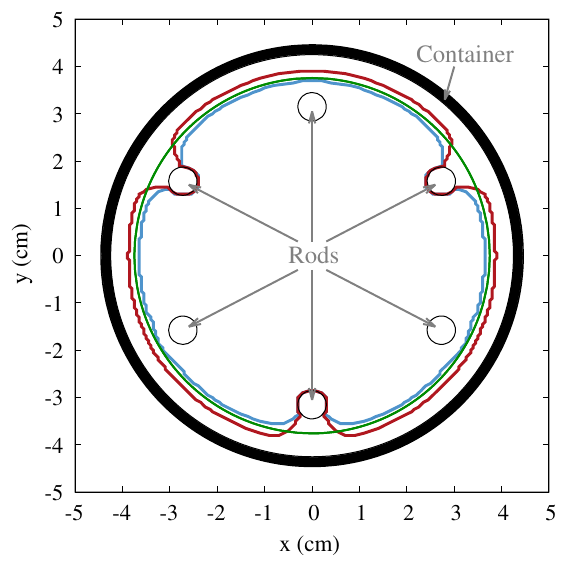
FIG. 3. Two-dimensional contour plot indicating the active BLM volume in the vicinity of high-voltage (blue line) and signal electrodes (red line). For comparison, the plot also delineates the electrode radius (green line), which is also the limit of the active volume assumed in the particle shower simulations. Results derive from numerical simulations of the charge induction on signal electrodes, based on the Green ’ s function of electrons in the electric field created by electrodes, rods, and walls of the ionization